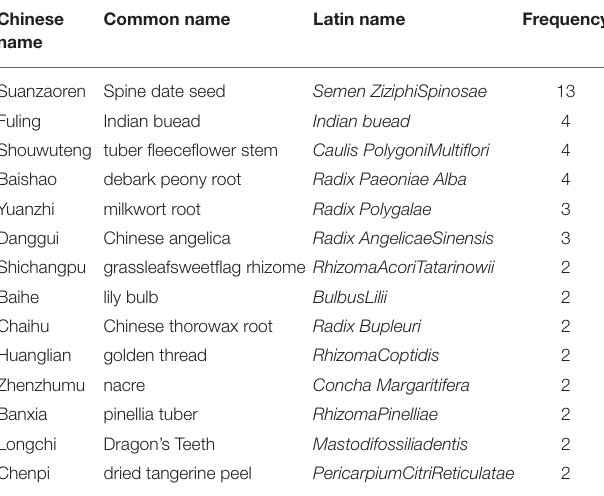
TABLE 2 | Analysis of the high frequency herbs in treatment of